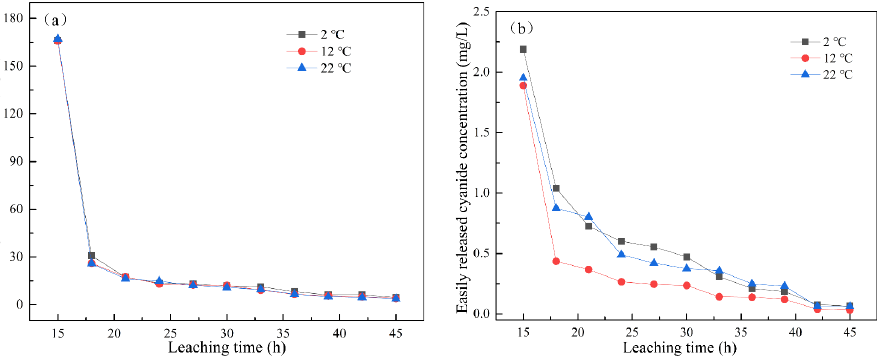
Figure 3. Effect of leaching temperature on the concentration of ( a ) total cyanide and ( b ) easily liberatable cyanide at different timepoints.